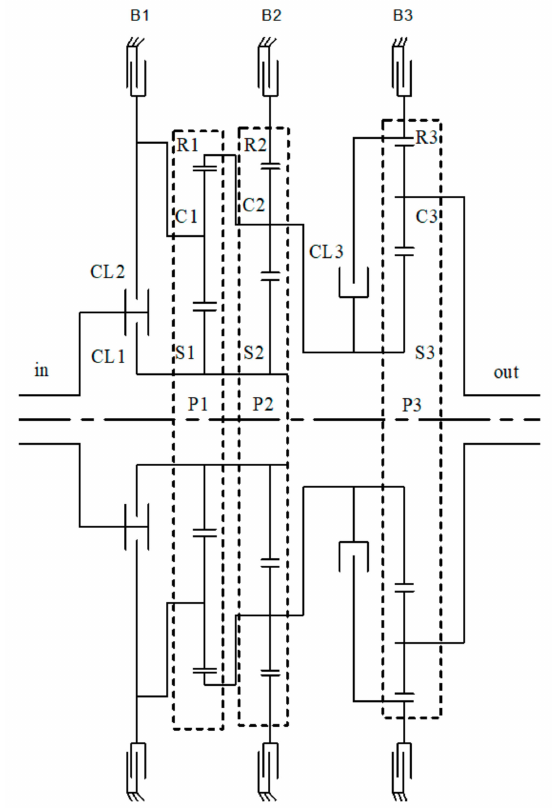
Figure 1. Three-planet gear drive